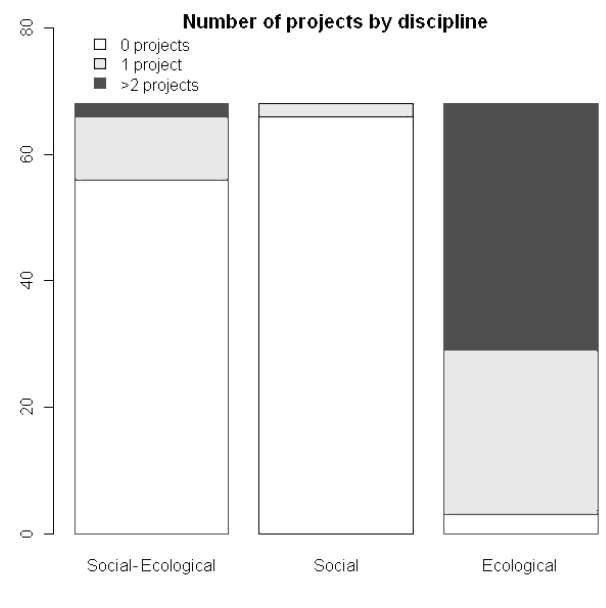
Fig. 3 . Long Term Ecological Research (LTER) graduate student responses to Question 11 from the broad survey: “How many of the following types of research projects are you involved